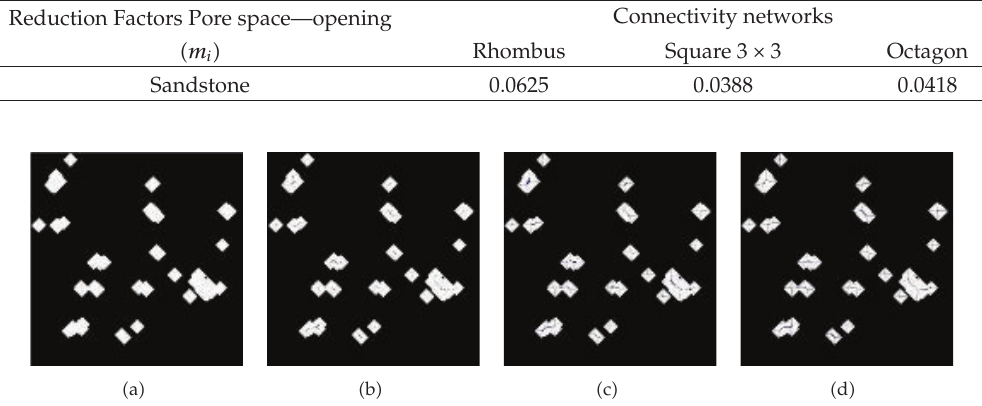
Figure 6: (cid:2) a (cid:3) Fifteen times of opening transformations applied at binary pore space; (cid:2) b–d (cid:3) opening image of (cid:2) a (cid:3) is used to extract pore connectivity networks of structuring elements (cid:2)(cid:2) i (cid:3) rhombus, (cid:2) ii (cid:3) square, and (cid:2) iii (cid:3) octagon (cid:3)